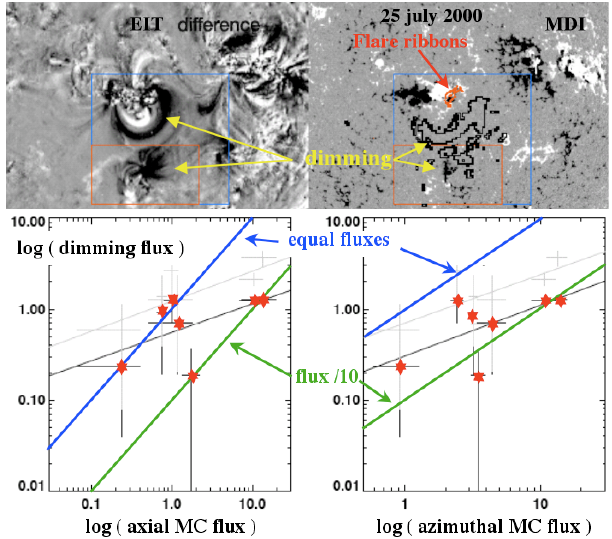
Fig. 11. Comparison of the magnetic flux found in the dimmings and in the associated MC for 7 events. The top left panel shows a base difference image for one event. The dimming extensions are reported on the co-temporal magnetogram in the right panel. The bottom panels compare the flux found in the dimmings with the axial and azimuthal flux found in the related MC. The red stars cor- respond to the mean of the absolute flux value between negative and positive dimming regions, and an azimuthal flux computed with MC length L = 1AU. The error bars are mainly computed from varying alignment offsets (between MDI and EIT), using two dimming lev- els, and using the range L = 0 . 5 to 2AU (Qiu et al., 2007).